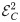
Pulse regime.(a) The total energy current J(t) = J
1(t) + J
2(t) as a function of time for three values of the external magnetic flux Φe = 0, 0.25, 0.5. The reservoir rescaled temperatures are θ
1 = 1, θ
2 = 10. (b) J(t) is shown for three sets of reservoirs temperatures {θ
1, θ
2} = {1, 10}, {1, 5}, {5, 10}. (c) J
1(t) and (d) J
2(t) for the same set of temperatures as in panel (b). In panels (b)-(d) the flux Φe = 0. Remaining parameters are fixed as: εJ = 4, EC2 = 1.5 and γ
1 = γ
2 = 0.05. The dimensionless time t is rescaled by the oscillator frequency ω.